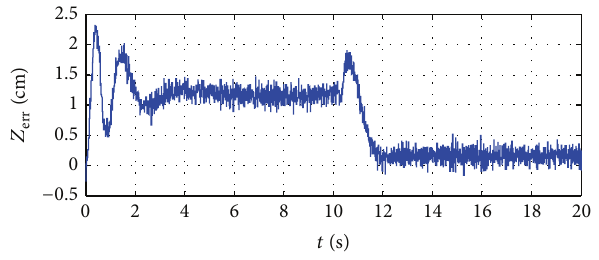
Figure 6: Position tracking error along the Z direction.